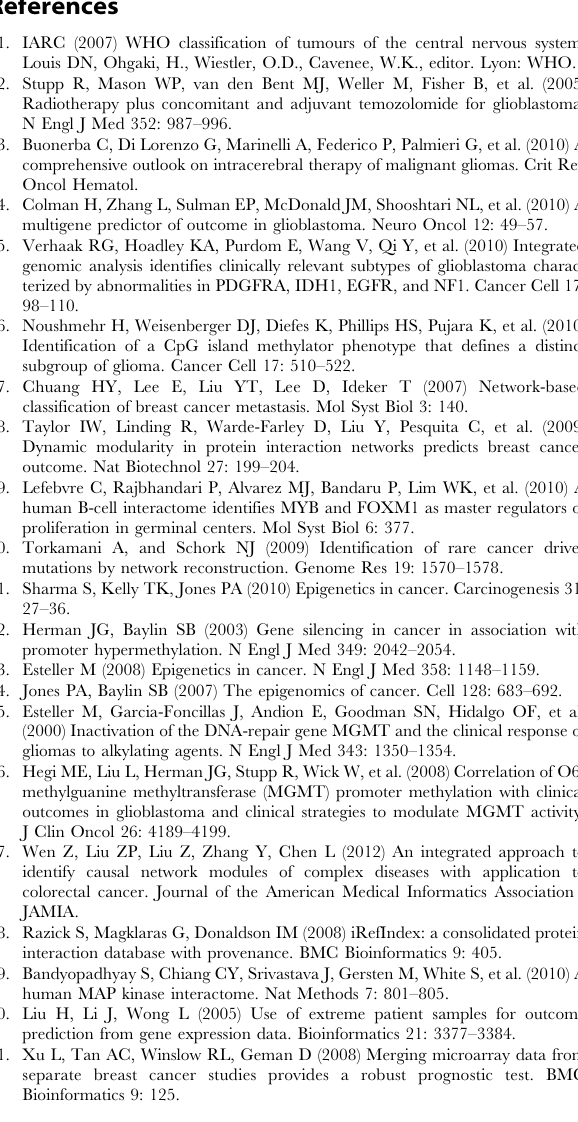
Table S1 Information of patient data used in this study. A survival time of two years is used as the cutoff to classify patients into Long Term Survivors (LTS) and Short Term Survivors (STS). Table S2 The set of twenty-five eModules identified using mRNA expression data only. Table S3 The set of seven mModules identified using DNA methylation data only. Table S4 The set of multi-analyte modules identified by the MAPIT algorithm. 38-gene set, set of prognostic genes for GBM patient outcome proposed by Colman et al. G-CIMP +